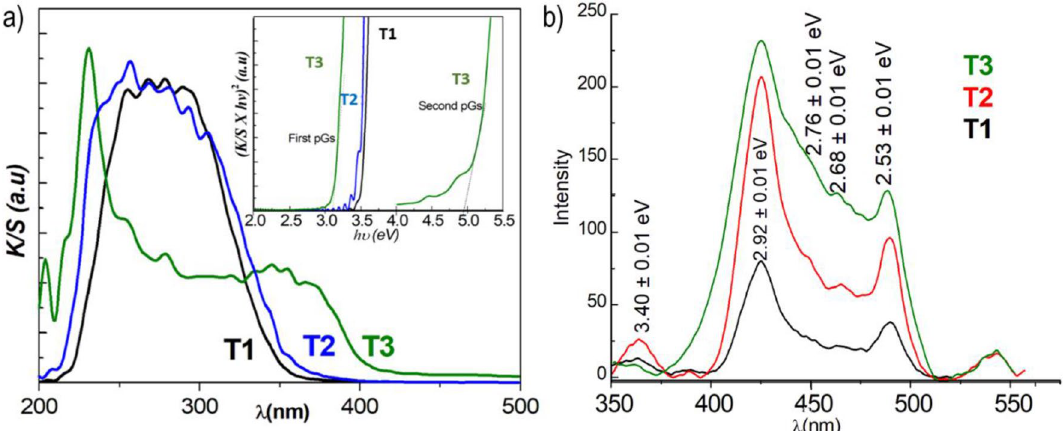
Figure 12. Reflectance diffuse spectra (after Kubelka–Mulk transformation) 93 of T1, T2, and T3 lamellar H 2 Ti 3 O 7 NTs, and (inset) plot (K/S × hν) 2 against hν showing the linear fitting to the main linear segment of the curve considering a direct band gap transition., according to the Tauc equation ( a ). Luminescence emission spectra of T1, T2, and T3 ( b